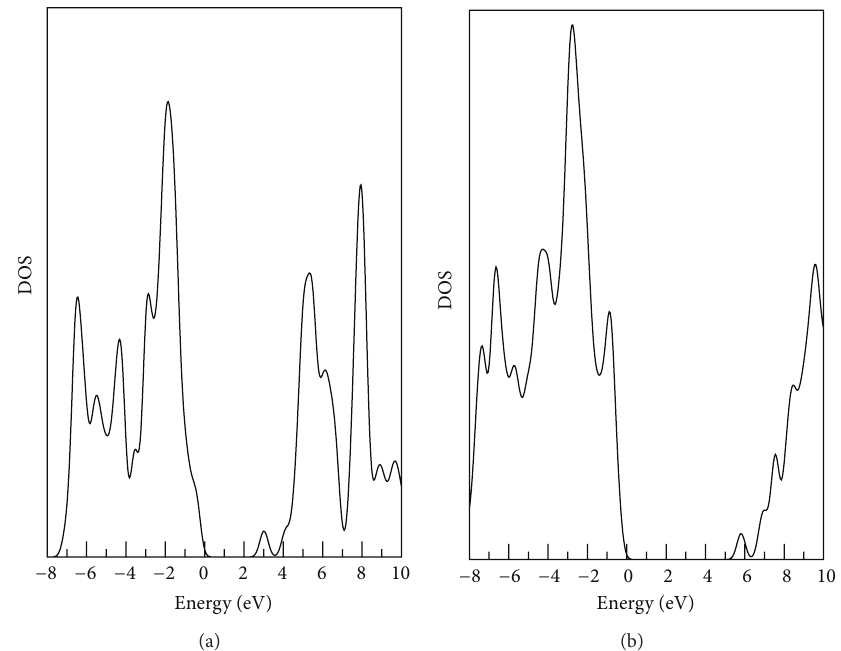
Figure 2: Total density of state of (a) GaN bulk and (b) Al 2 O 3 bulk. The level Fermi is located in zero.